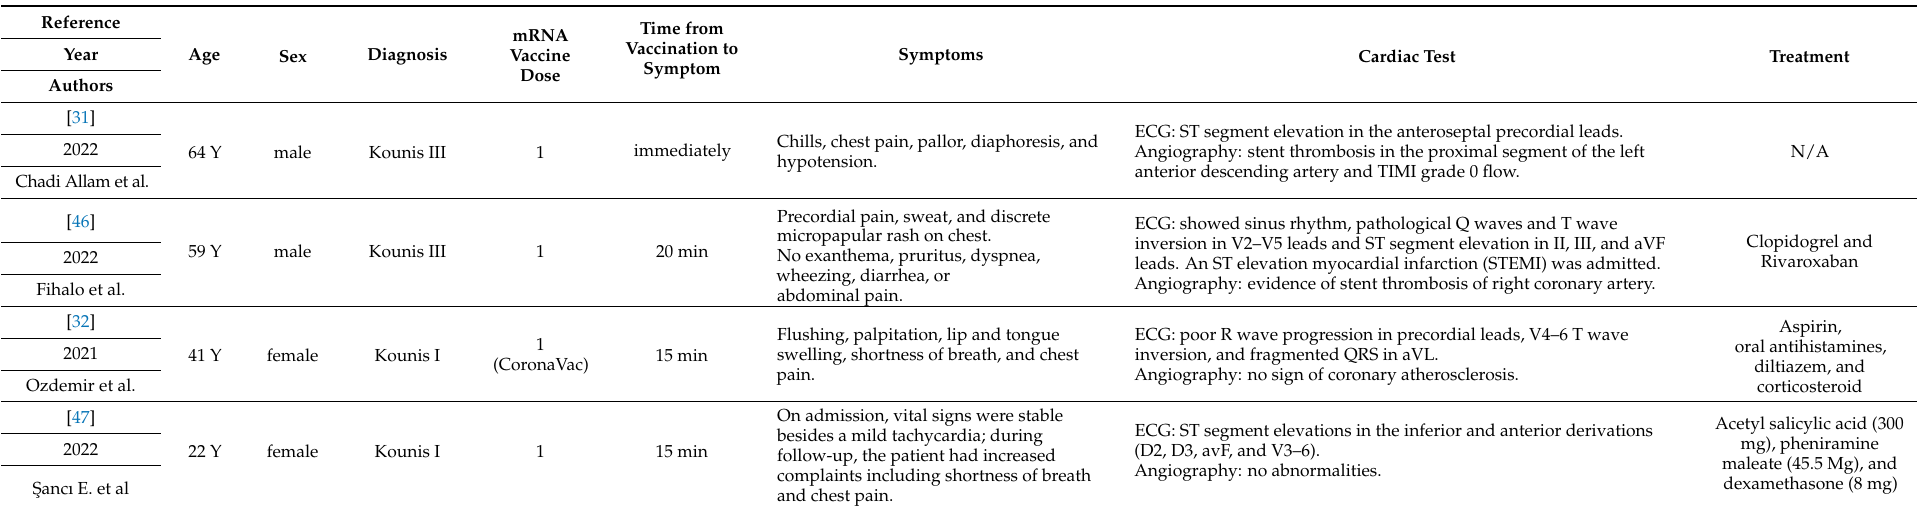
ECG: ST segment elevations in the inferior and anterior derivations (D2, D3, avF, and V3–6). Angiography: no